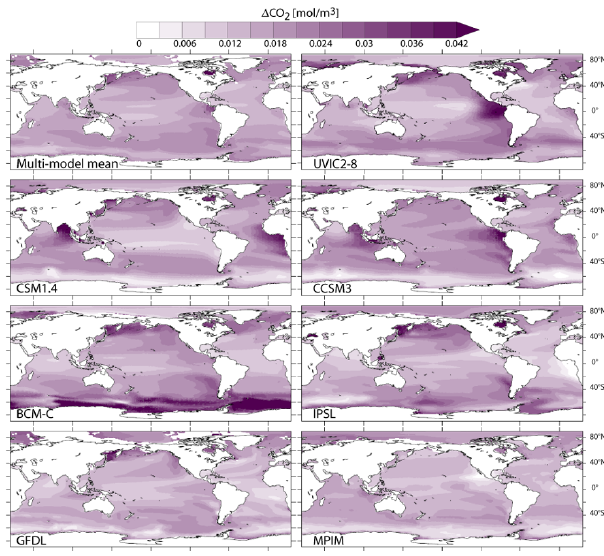
Fig. 9. Projected changes in CO 2 in the UML (100 to 600m depth) for the SRES A2 scenario. Changes are for 2090s relative to 1870s (decadal average). The multi-model mean is given in the upper left panel.